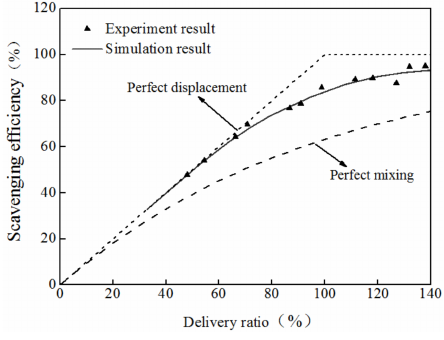
Figure 8. Scavenging process comparison.